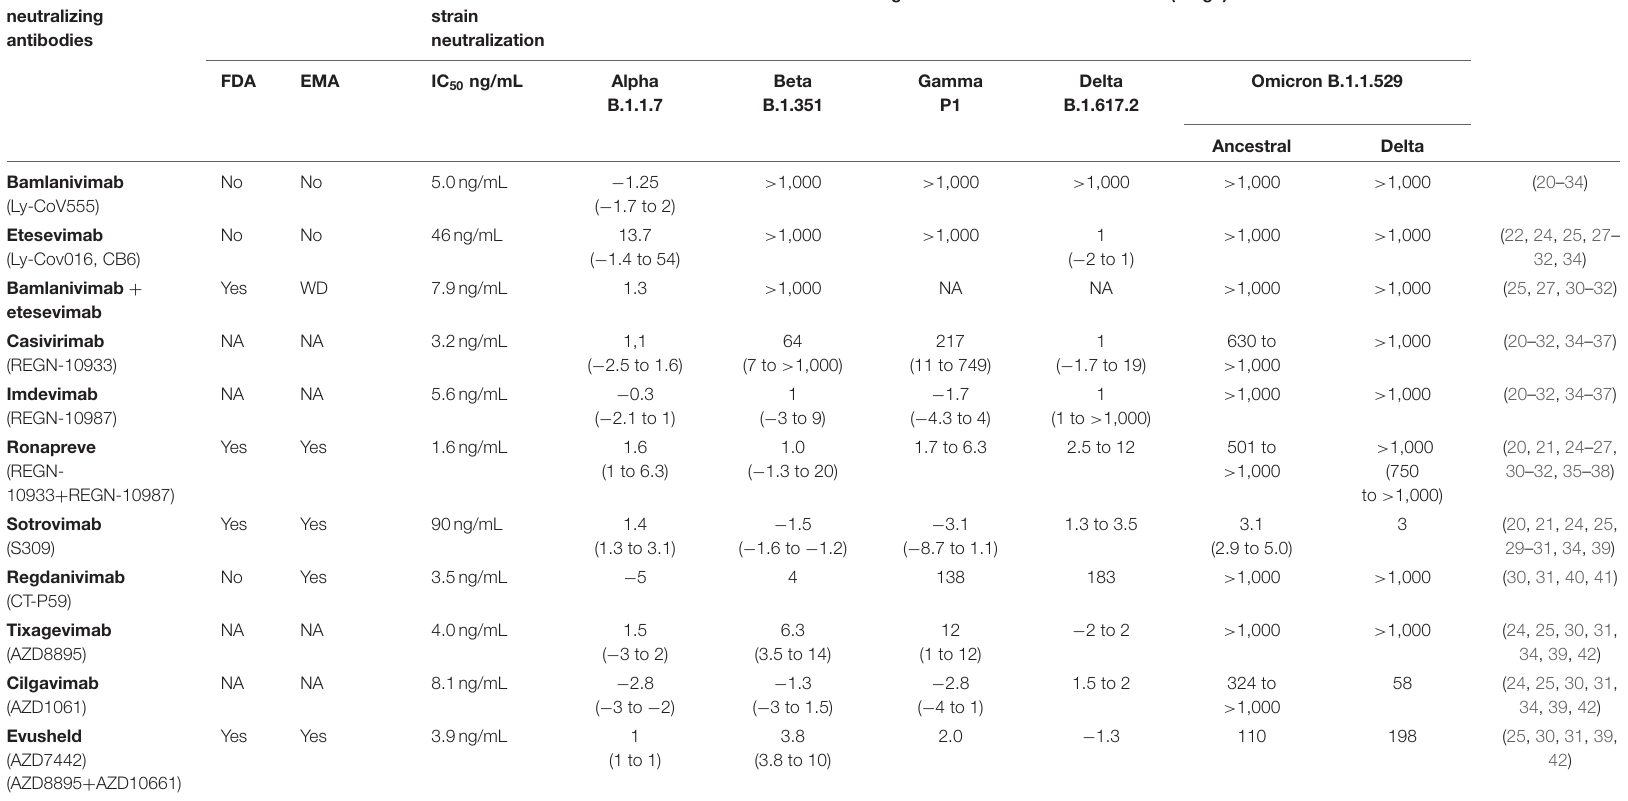
Fold change of neutralization titers median